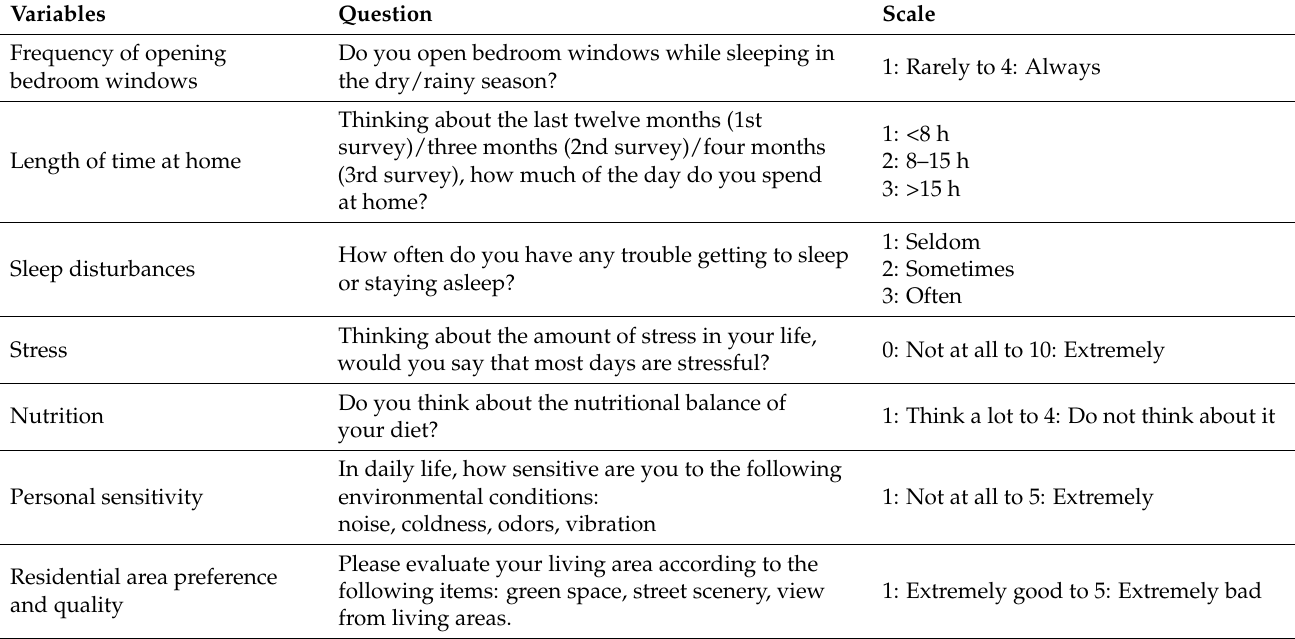
Table 10. Questions and evaluation scales for measuring moderating variables in the final version of the structural equation